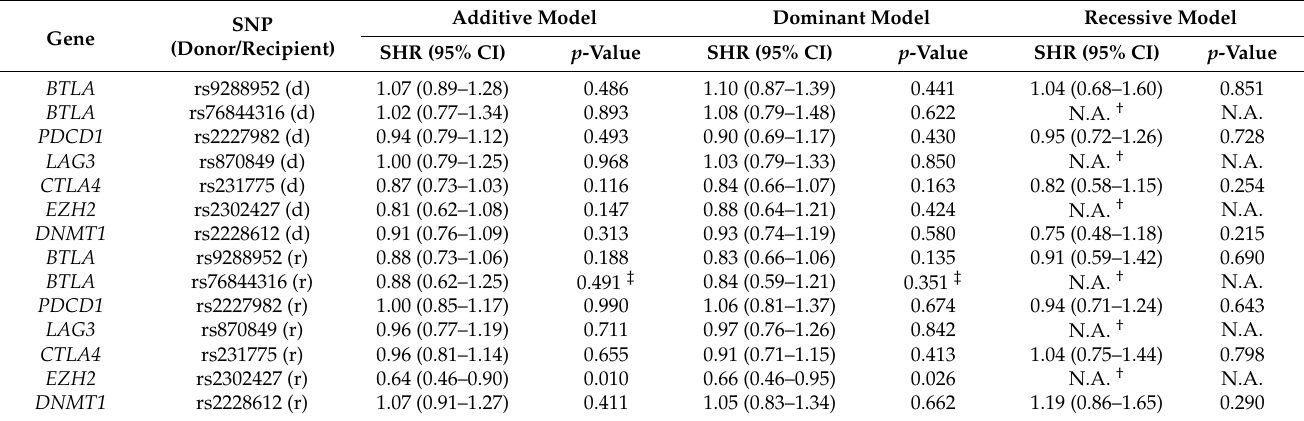
Table 1. Multivariable regression of grade 2–4 aGVHD on donor and recipient SNPs.